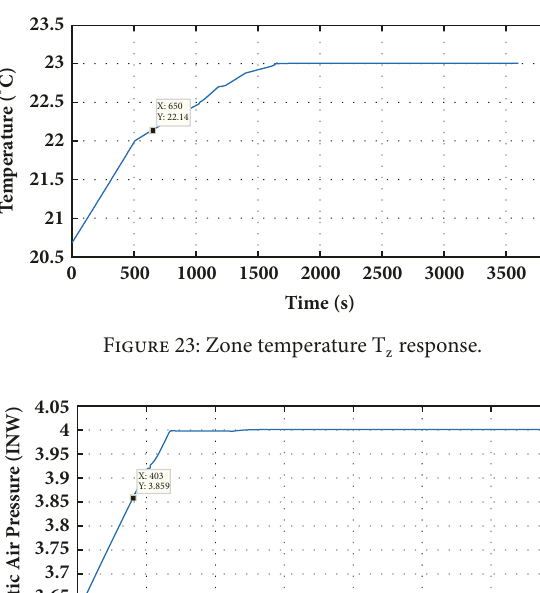
Figure 22: Block diagram for the AHU 1 state space model with controller.